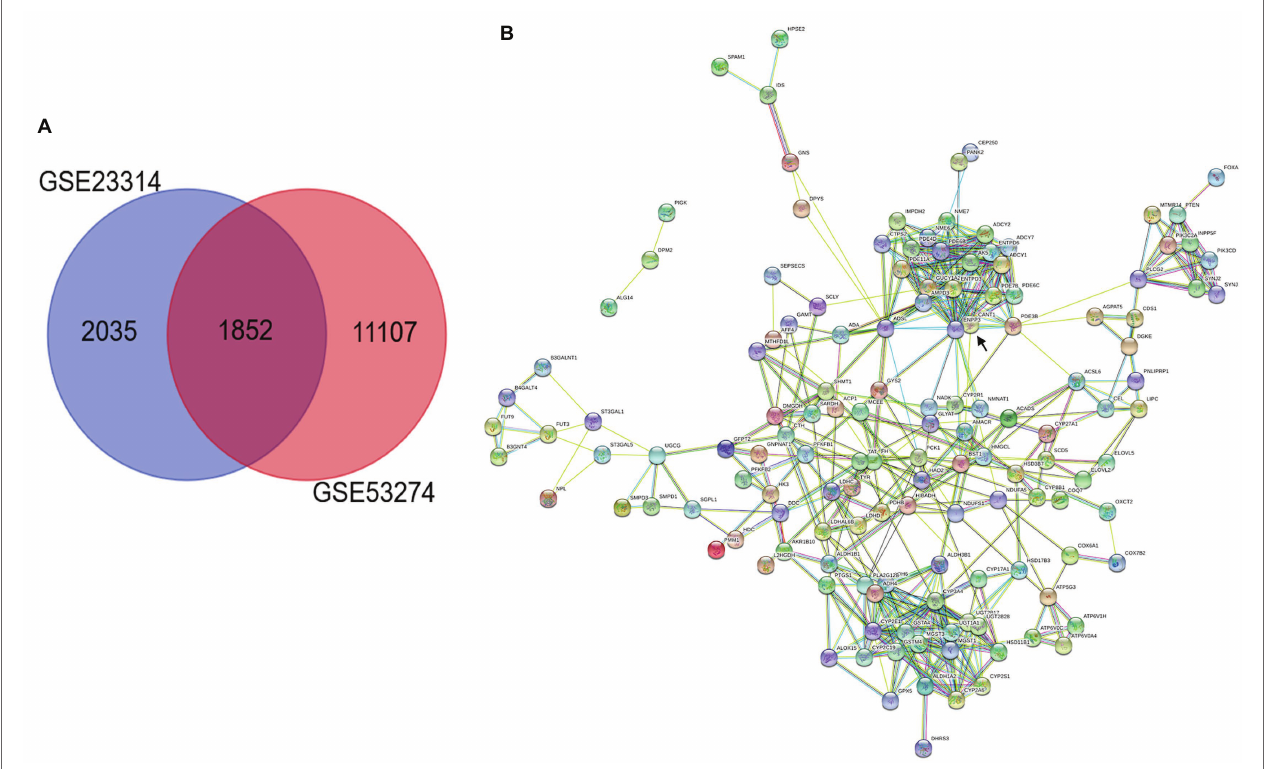
FIGURE 1 | Integrated analysis of GEO datasets identified DEGs. (A) Venn diagrams of common DGEs between two combined datasets (GSE23314 and GSE53274). Each circle represents a dataset, and the overlap between the circles is the overlap between the datasets. (B) PPI network integration of the common DGEs. Each node is a gene, and the connections between nodes represent the interaction of these biological molecules. ENPP3 (black